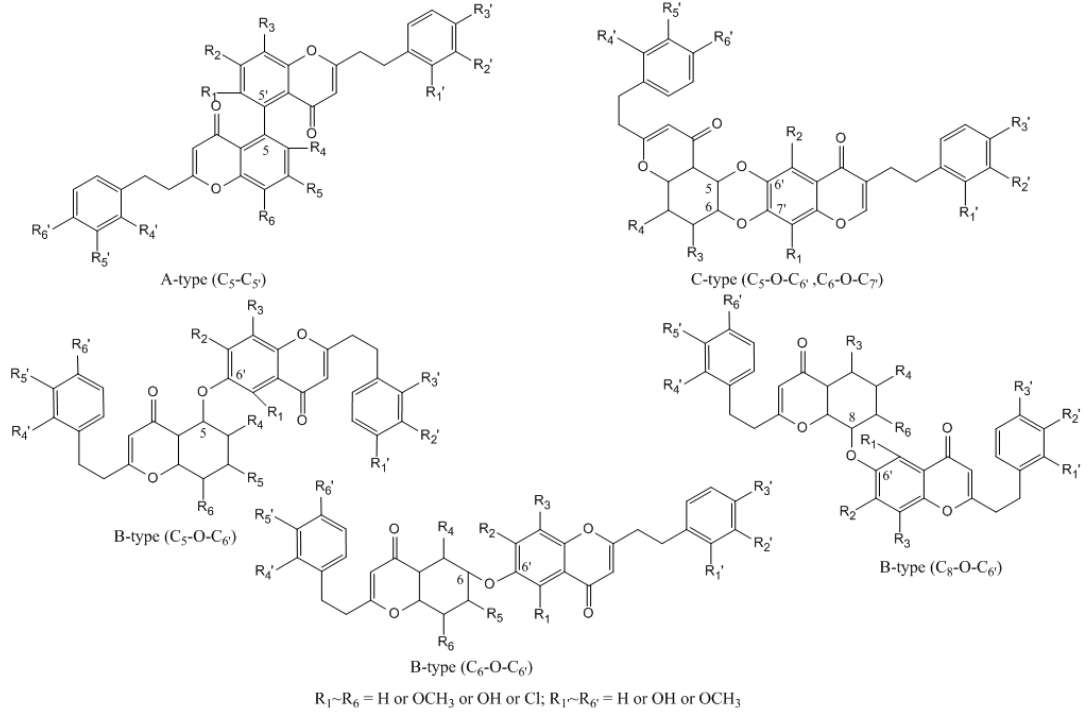
Figure 3. The main structures of bi-2-(2-phenylethyl)chromones (A-type, B-type, and